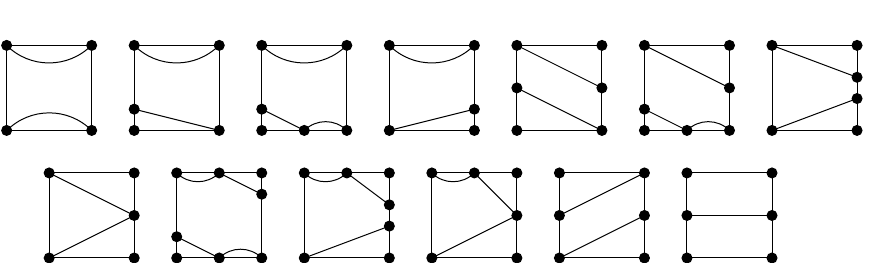
Figure 2. Two available frames.